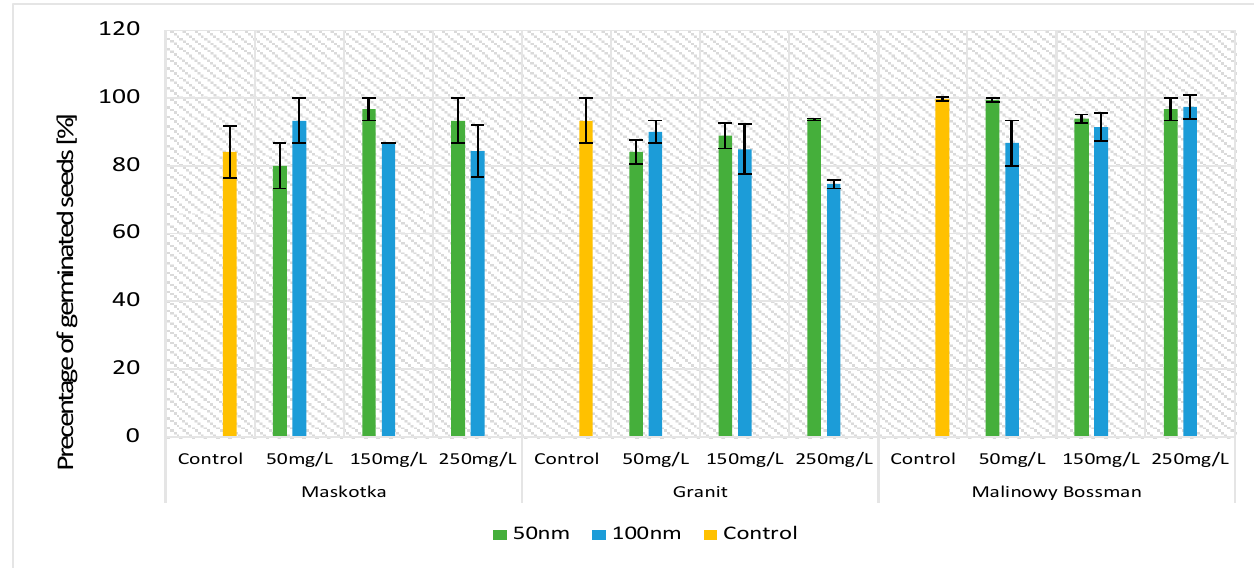
Figure 2. Effect of zinc oxide NPs on the germination percentage (GP) of tomato seeds after 5 days of incubation. All data are the mean of 3 replicates and are demonstrated on vertical bars (±SD). It was calculated that there are no significant differences between the treatments at p -value ≤ 0.05.